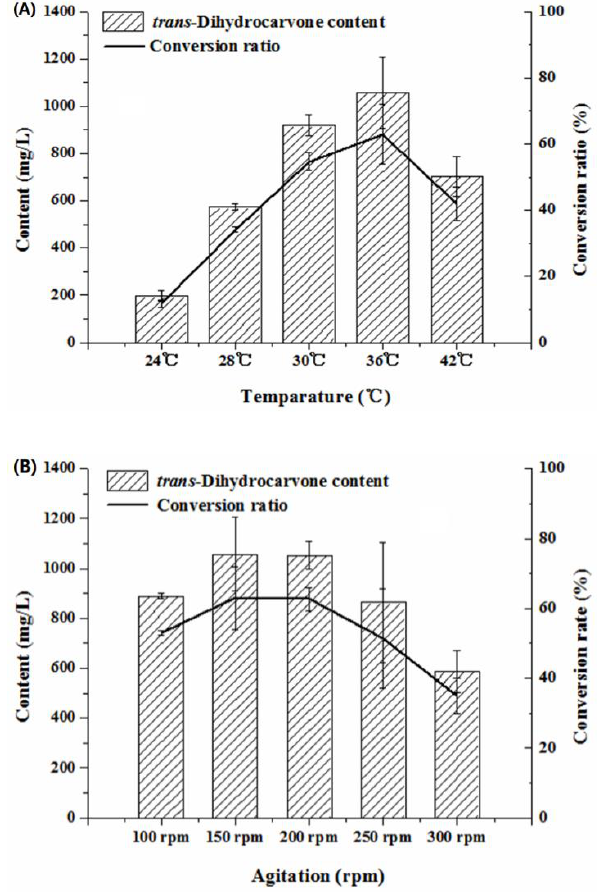
Figure 8. Effect of culture conditions on the production of trans -dihydrocarvone by Klebsiella sp. O852 (limonene of 1680 mg/L was added as substrate). ( A ) Effect of temperature on the production of trans -dihydrocarvone. ( B ) Effect of agitation on the production of trans -dihydrocarvone.